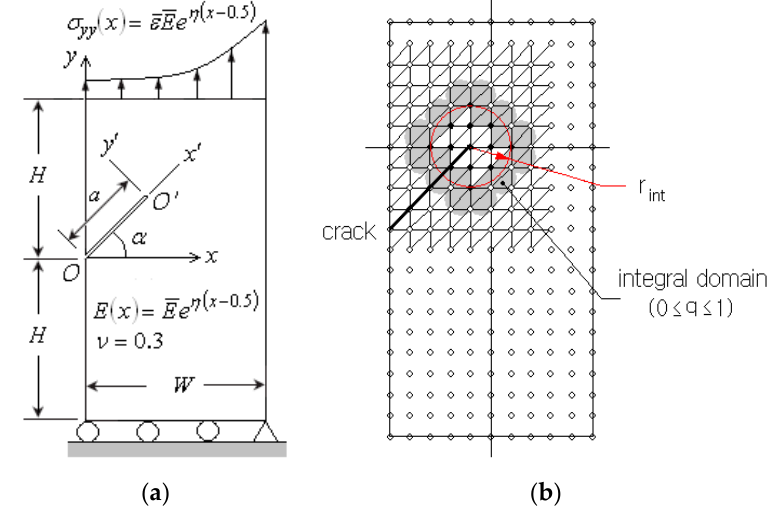
Figure 8. ( a ) An FGM plate with an inclined edge crack under the exponential distribution load, ( b ) a uniform NEM grid and the domain of integration (235 nodes).